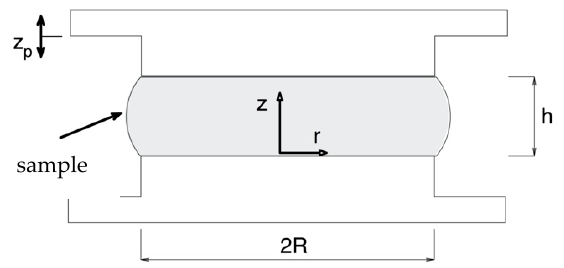
Figure 7. Schematic of squeeze film geometry showing a sample under test (not to scale).